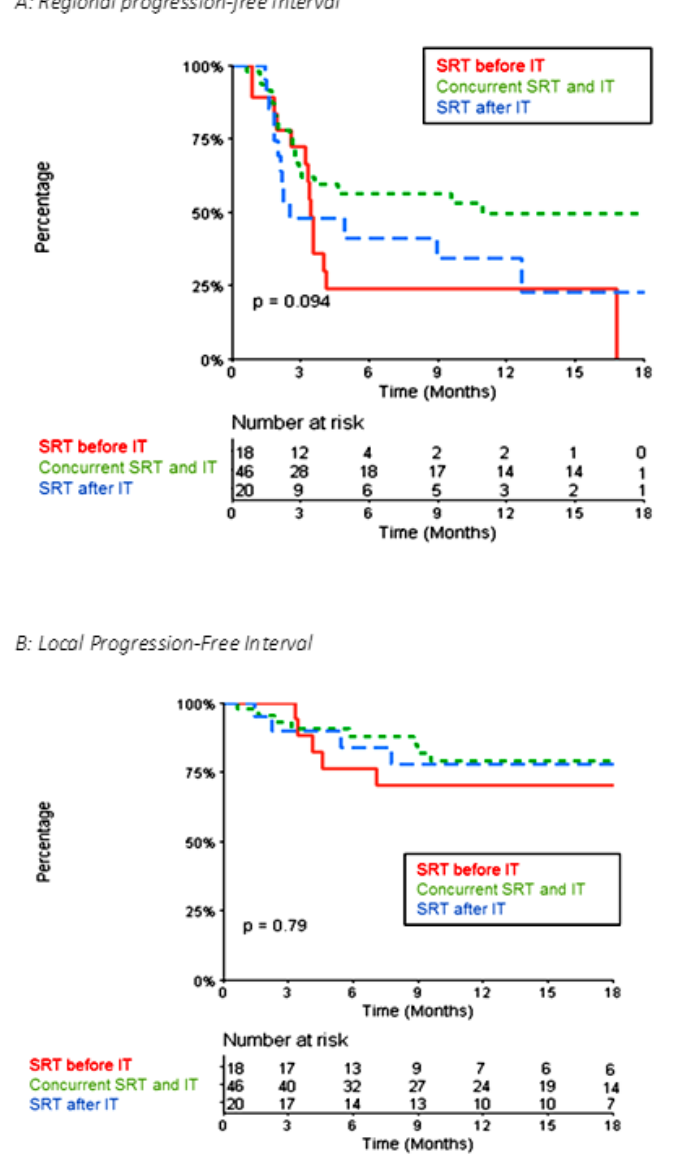
Figure 4. Kaplan–Meier Curve of Local Progression-Free Interval ( A ) and Local Progression-Free Interval ( B ) comparing the ‘concurrent SRT and IT,’ ‘SRT before IT,’ and ‘SRT after IT’ groups for the 84 metastases.